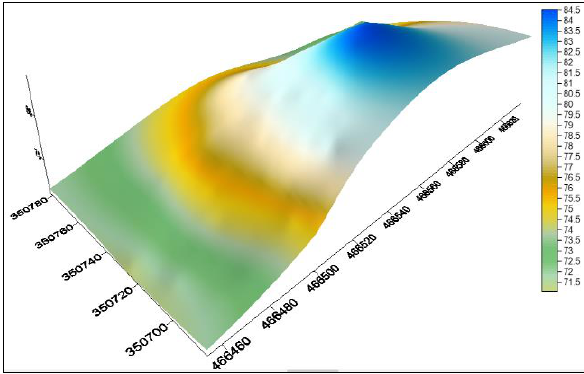
Figure 6. DTM generated from GCPs for rubber trees